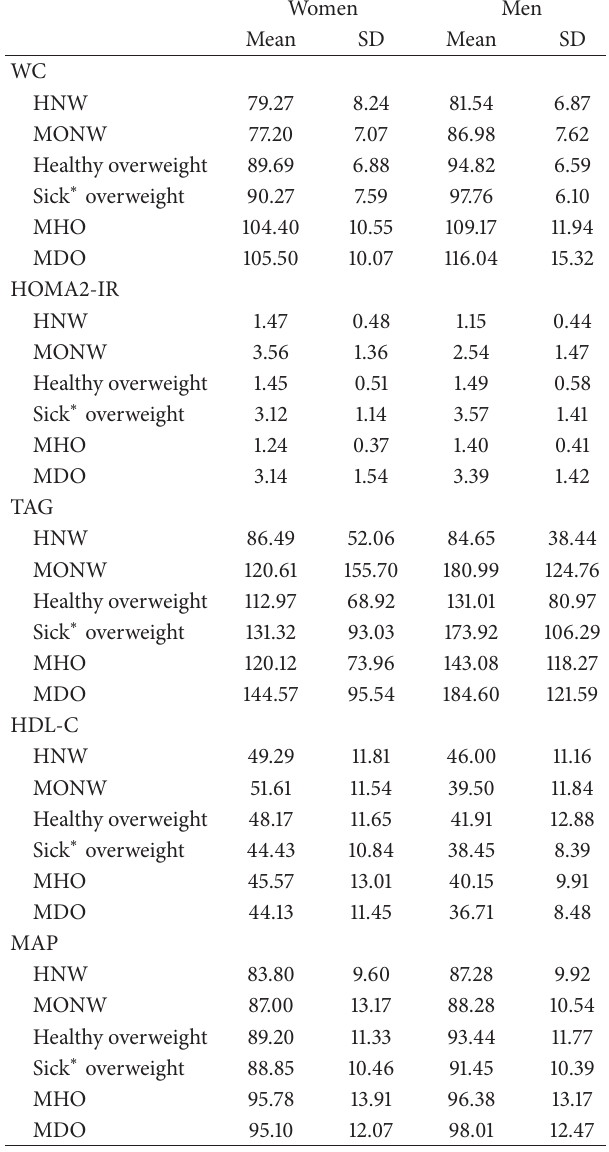
Table 6: Metabolic variables behavior of each metabolic phenotype according to sex. Maracaibo City Metabolic Syndrome Prevalence Syndrome, 2013.